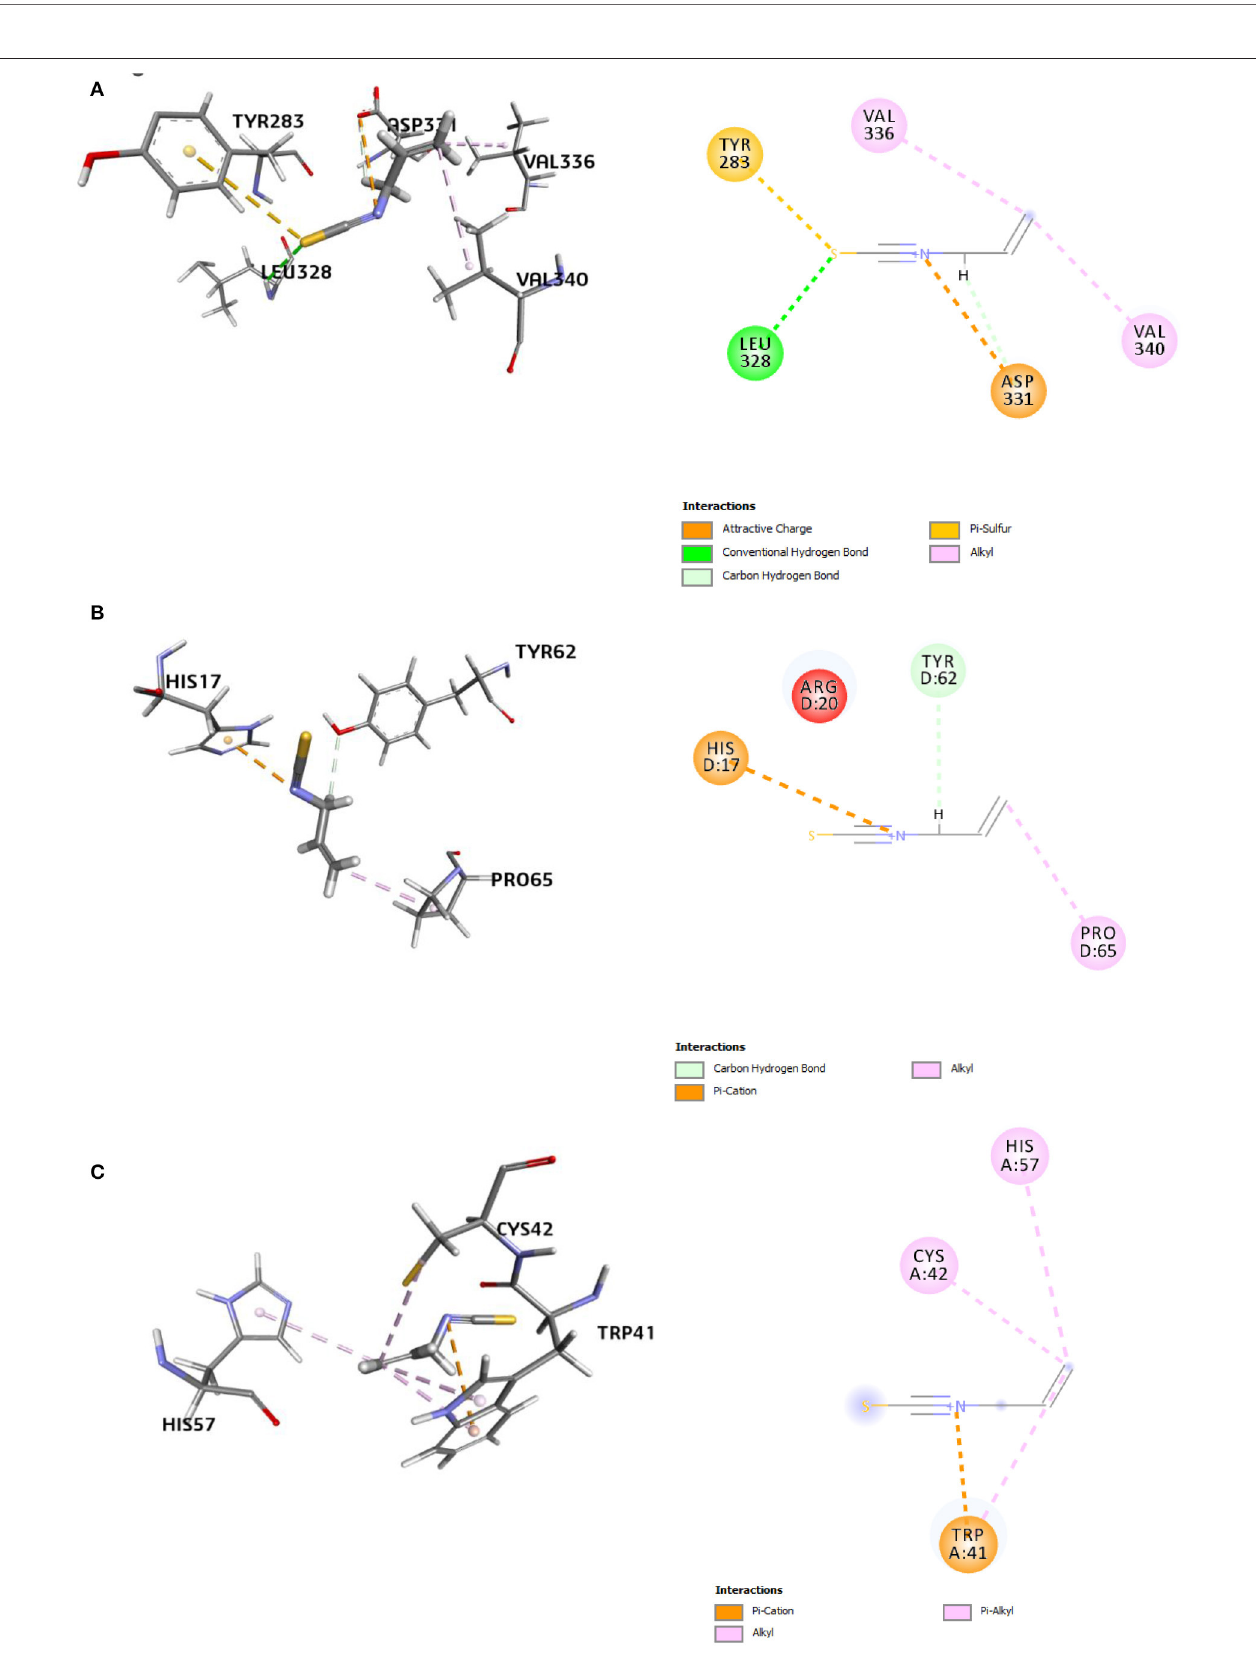
FIGURE 9 | 3D and 2D representations of the AITC-bound target sites of (A) chitin synthase (CS), (B) 2,3-dihydroxy benzoic acid decarboxylase (6m53), and (C) trypsinase (1try). Frontiers in Plant Science |